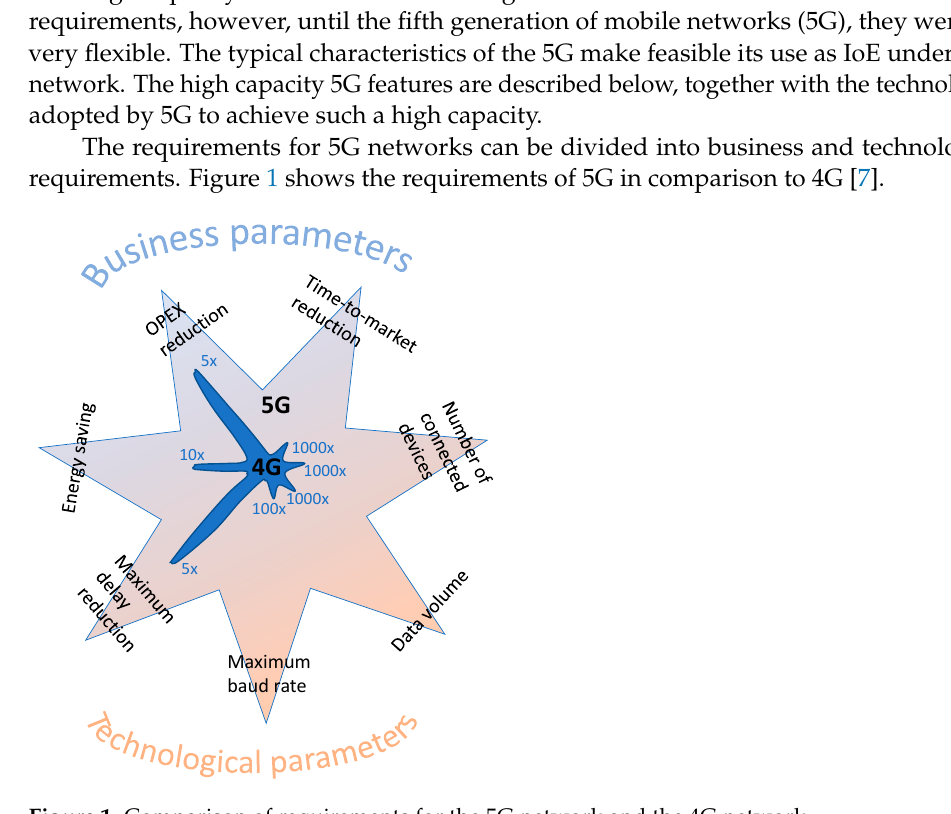
Figure 1. Comparison of requirements for the 5G network and the 4G network.